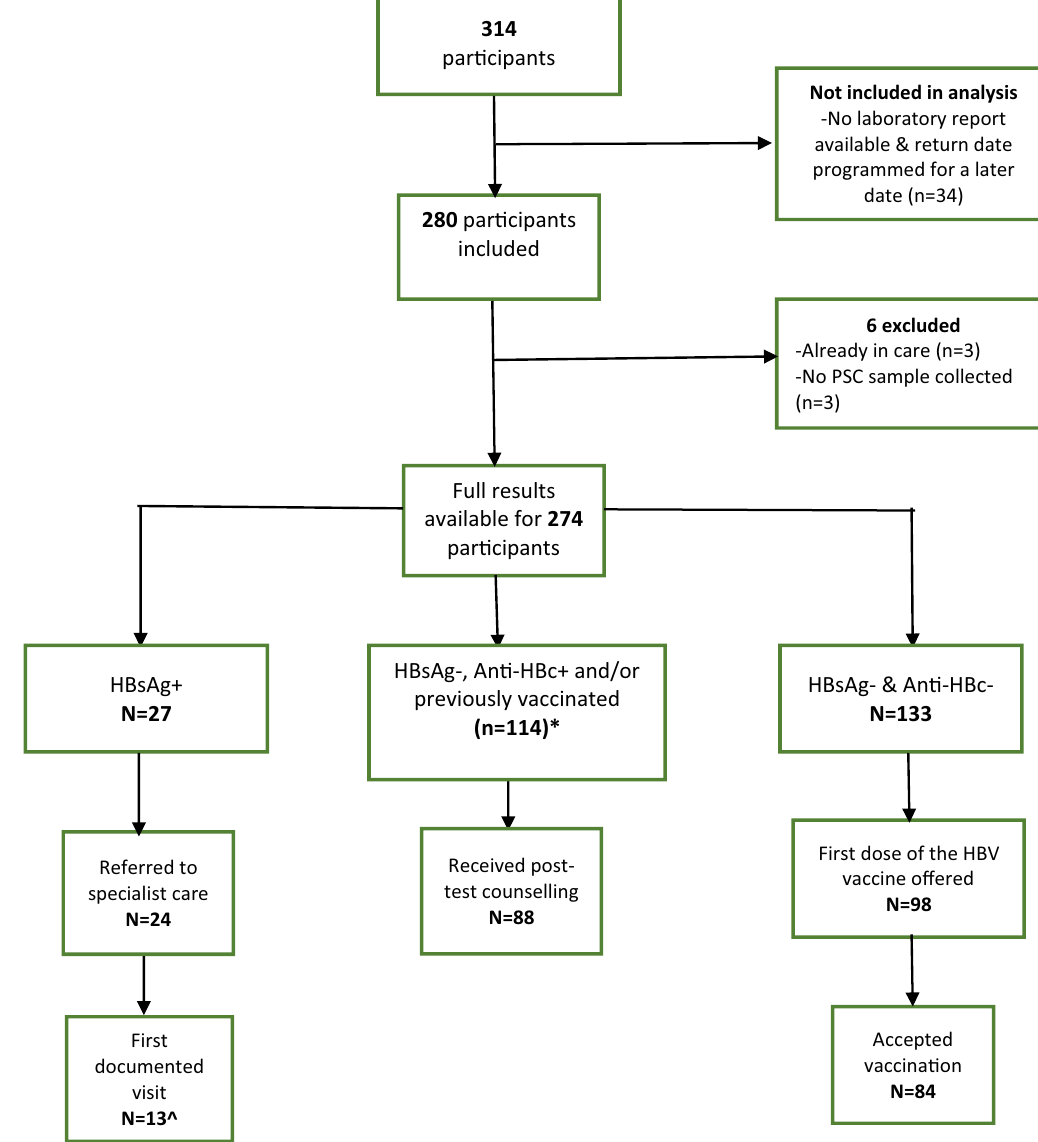
Figure 1. Flow chart of participants in the HBV-COMSAVA study and overall linkage to care proportions. *Fourteen participants reported being previously vaccinated and were anti-HBc positive. ^16 accepted the direct referral to one of the two hospitals linked to the project, of which 12 had a documented first visit with a specialist. Eight participants preferred visiting their own physicians (not the hospitals included in the study) due to distance and transportation issues, of which one had a documented first visit. HBsAg Hepatitis B surface antigen, anti-HBc antibody against hepatitis B virus core antigen, HBV hepatitis B